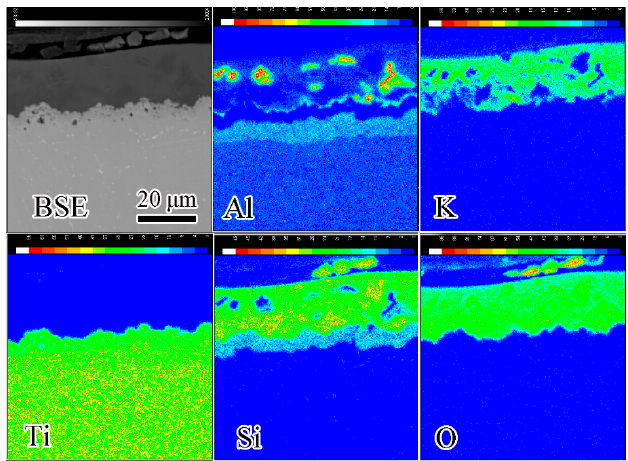
Figure 8. Elemental mapping of coating/alloy interface after oxidation at 900 °C for 100 h by electron probe microanalysis (EPMA). probe microanalysis